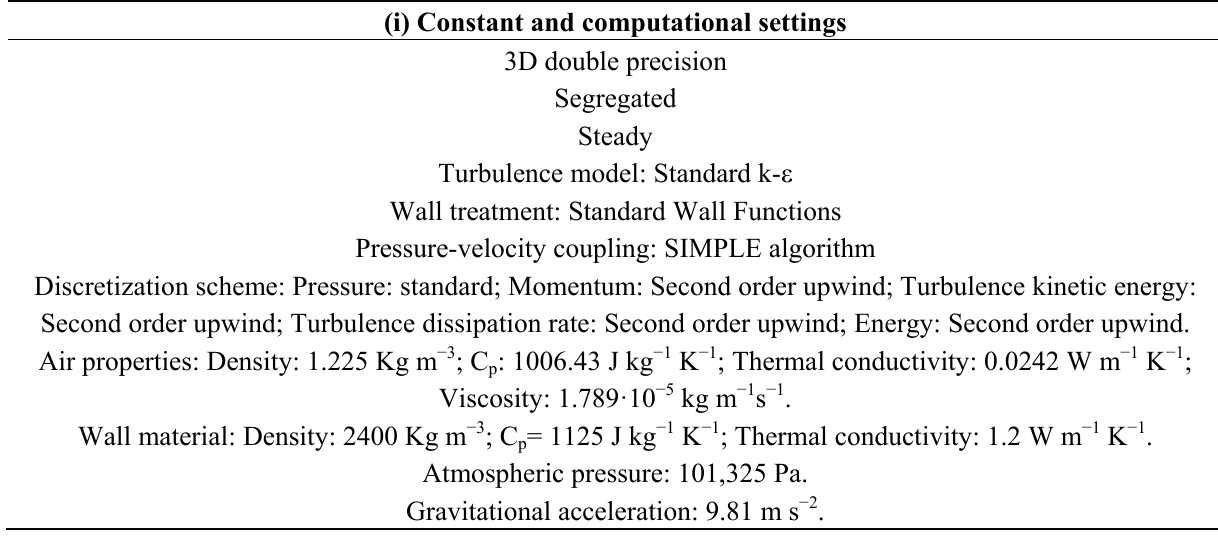
Table 2. Main inputs and BC at CFD